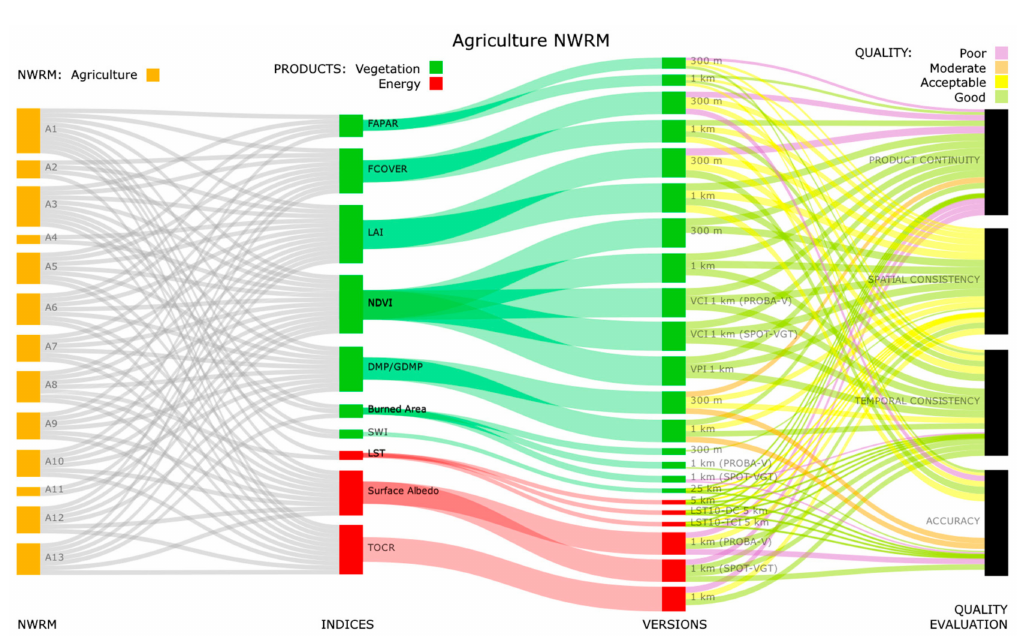
Figure 3. Sankey diagram linking the vegetation and energy indices to the agriculture NWRM that they can be employed to study and monitor, according to previous research works, and to their versions available in the Copernicus Global Land Service, which are in turn linked to expected quality. The short-names of the catalogued NWRM are explained in Table